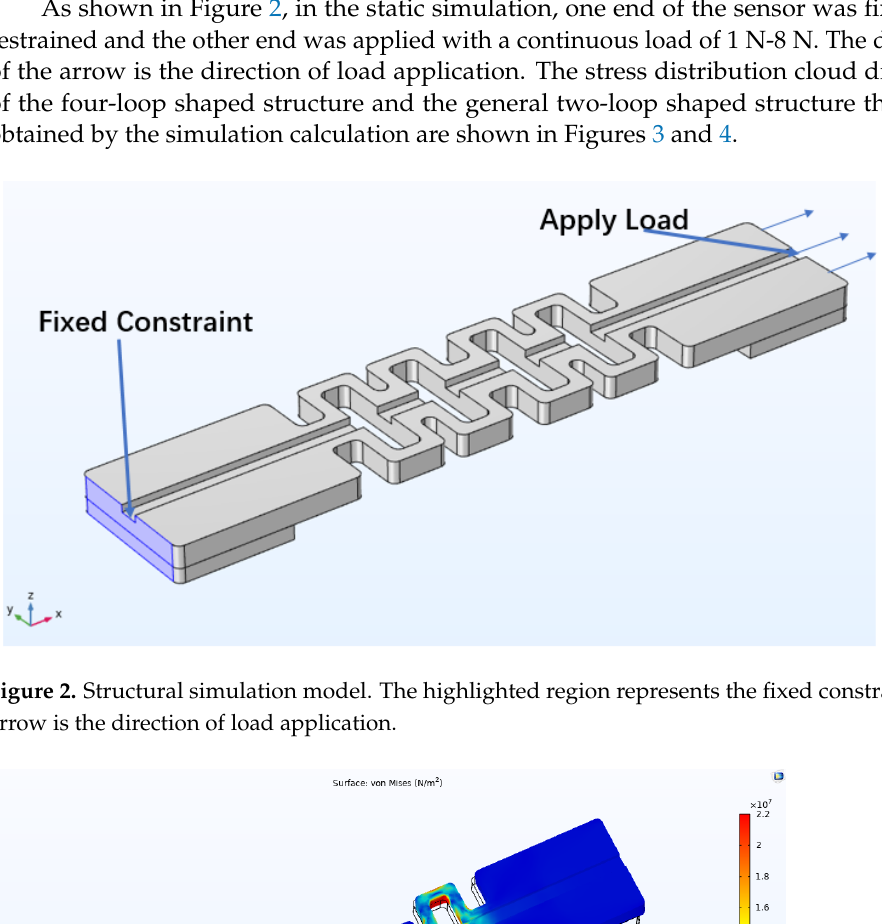
Figure 4. Stress contour plots of PLA-AE-FBG2.